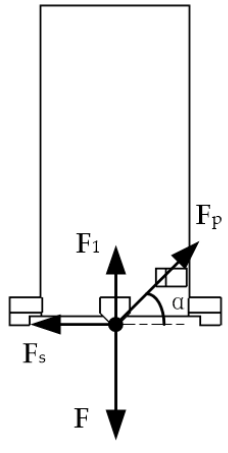
Figure 10 . Force diagram of cylindrical push rod.